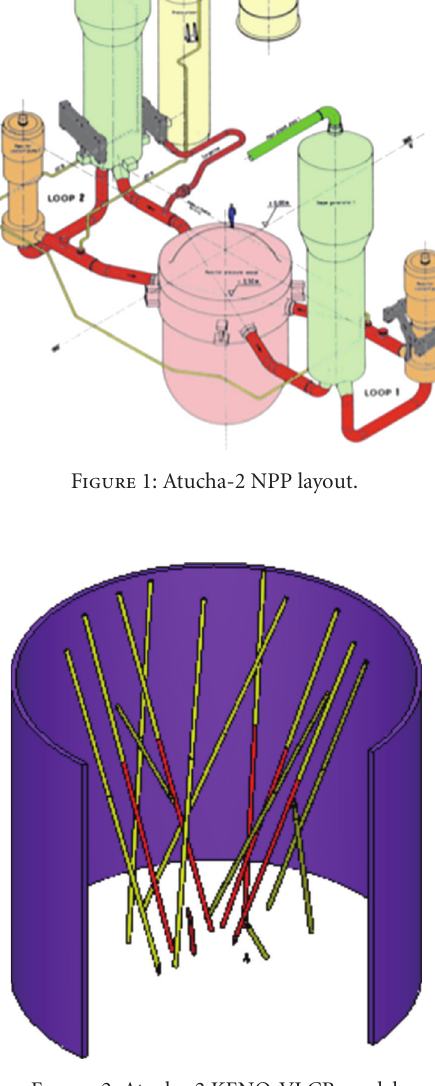
Figure 2: Atucha-2 KENO-VI CR